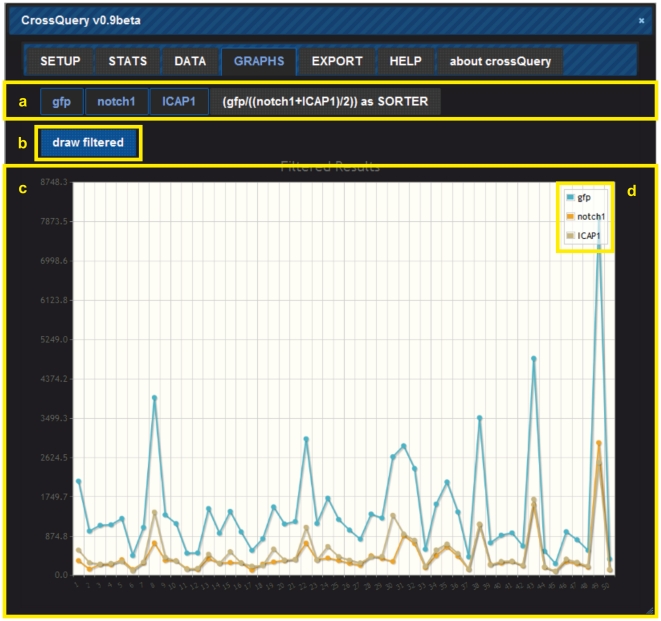
Using the Graphs tab of CrossQuery allows(a) selection of data-columns to be rendered as lines in a plot. (b) Clicking the "draw filtered" button will refresh the (c) line-graph view and the legend (d). Plotting is helpful when looking for general trends in different subsets of data, e.g. in the provided example all expression peaks are present in all lines ( = data-columns), but amplitudes and baseline expression differ strongly.